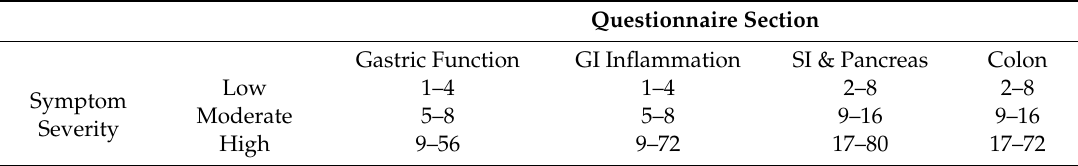
Table 3. Priority status based on scores from the digestive health